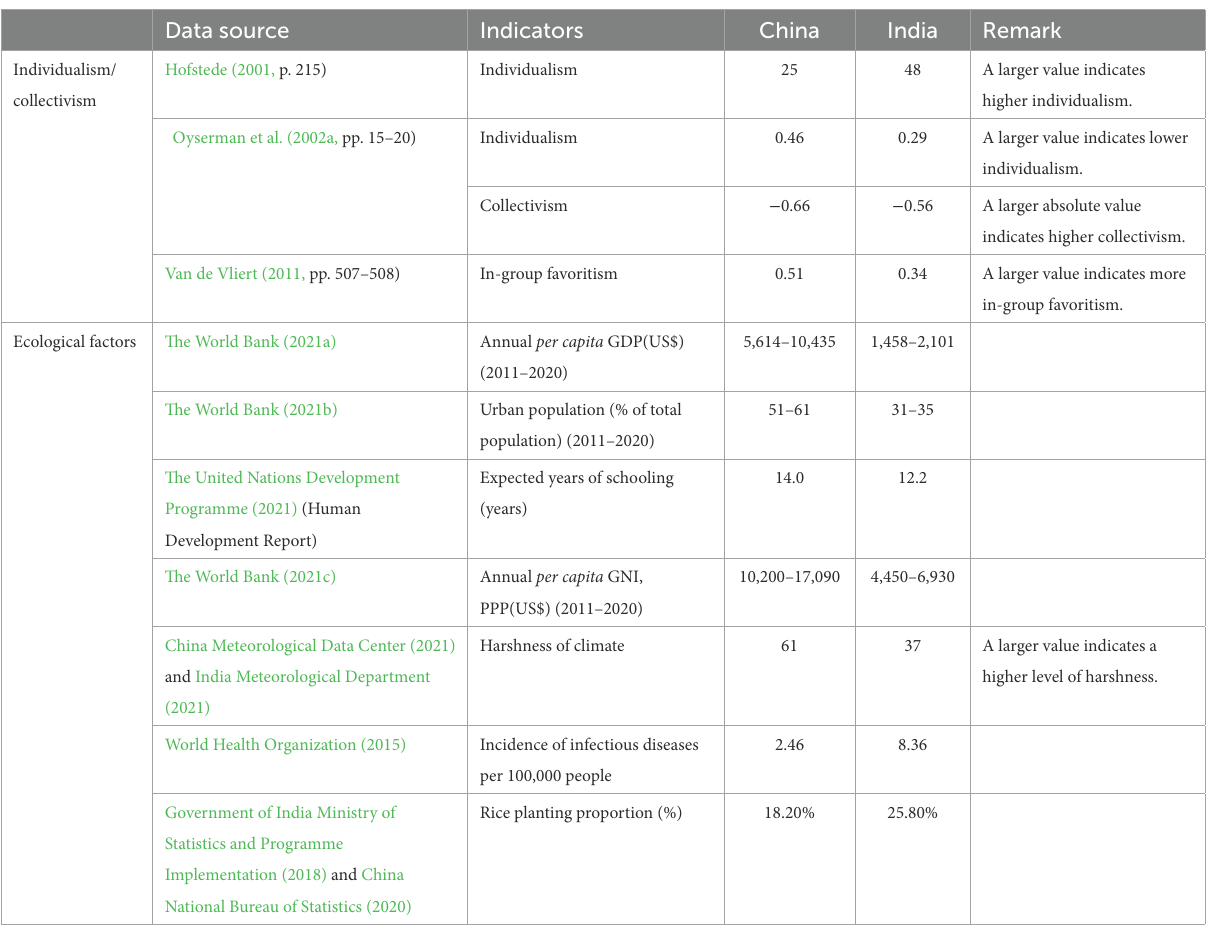
TABLE 1 Individualism or collectivism and socioecological factors of China and